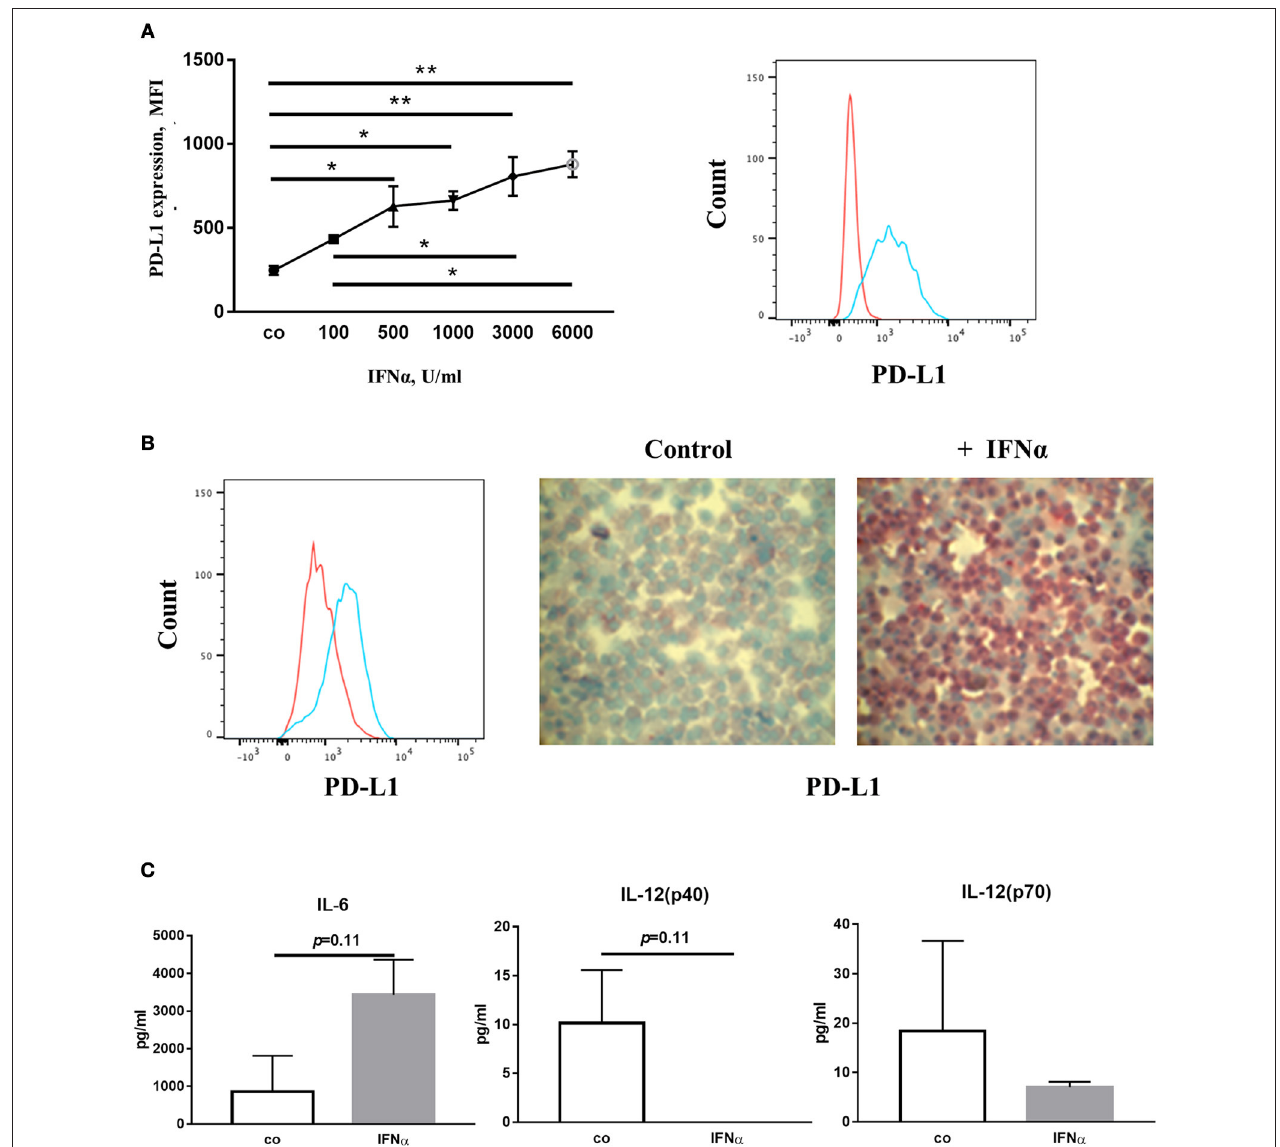
FIGURE 4 | IFN α up-regulates PD-L1 expression on human dendritic cells. (A) FACS analysis of PD-L1 expression on the surface of mDC. Myeloid DC were isolated, treated for 24h with IFN α and analyzed with flow cytometry. The results are presented as column mean, error bars and mean connected and statistically analyzed using ordinary one-way ANOVA with the Tukey’s multiple comparisons post-test, n = 2, * p < 0.05 and ** p < 0.01. (B) FACS analysis and Immunocytochemistry (ICH) of PD-L1 expression on the surface of MoDC. MoDC were treated for 24h with 1,000 U/ml IFN α and analyzed with flow cytometry. Alternatively, cytospin slides were produced and ICH was performed using an anti-PD-L1 primary antibody followed by a biotinylated secondary antibody. FACS histograms (red-control, blue-IFN α ) and ICH pictures are representative for independent experiments. (C) Cytokines in the supernatant of the IFN α -treated DC analyzed with Luminex assays. The results are presented as column bar graphs and statistically analyzed using unpaired T -test, n =